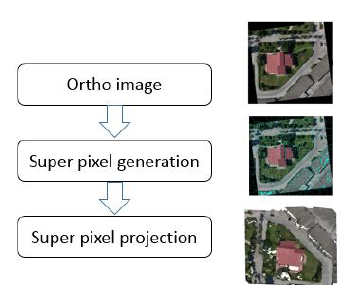
Figure 3. Super pixel generation and